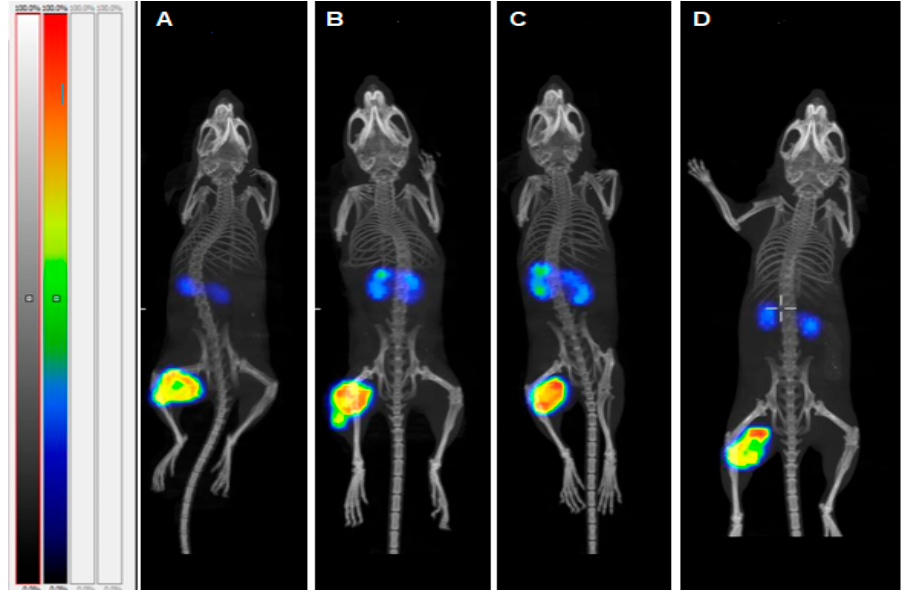
Figure 7. SPECT/CT imaging (maximum intensity projection) of HER2-expressing SKOV3 xenografts for pretargeting using ( A ) [ 177 Lu]Lu- HP16 , ( B ) [ 177 Lu]Lu- HP17 , ( C ) [ 177 Lu]Lu- HP18 , and ( D ) [ 177 Lu]Lu- HP2 4 h after injection. The color scale bar represents a relative activity normalized to the activity in tissues with the highest uptake in each image.